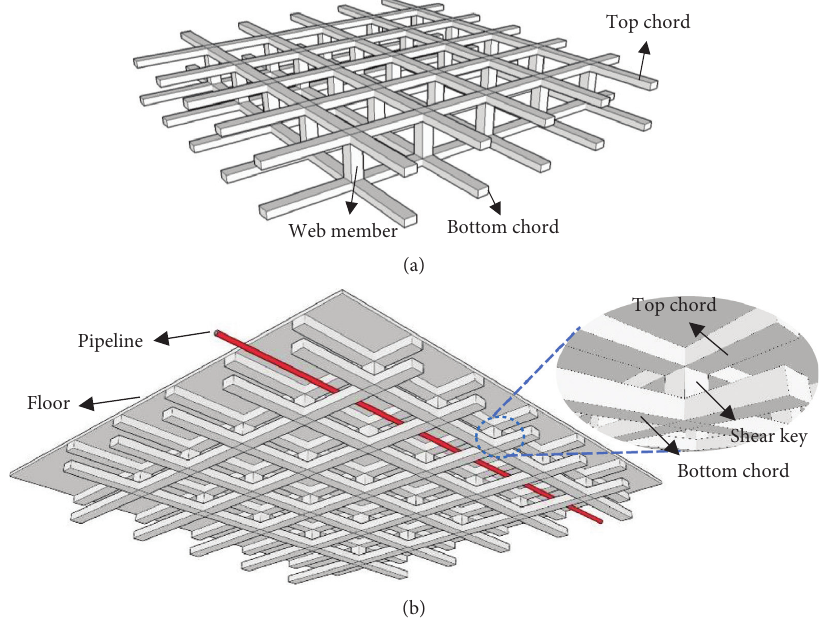
Figure 1: Structure composition schematic diagram. (a) Reinforced concrete open-web grid. (b) Reinforced concrete open-web sandwich plate